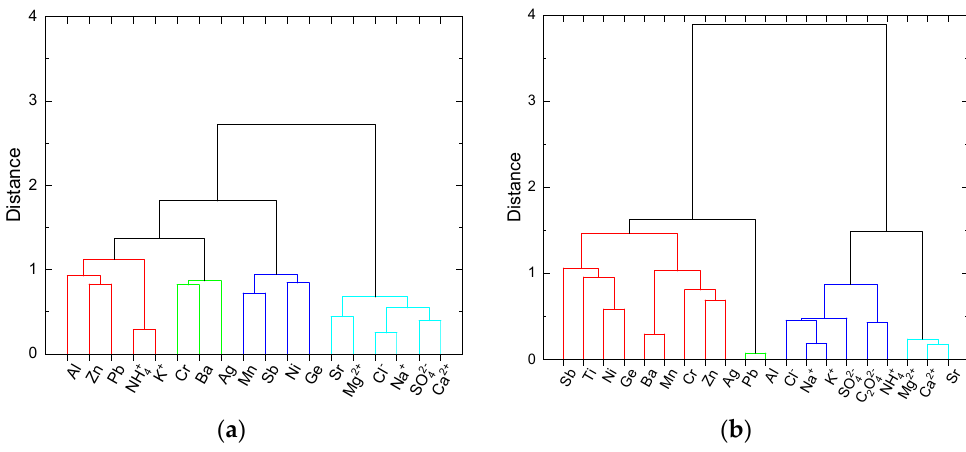
Figure 5. Hierarchical dendrograms showing clustering of water-soluble ions and elements in water ( a ) and sediment ( b ) samples collected in July and October sampling sessions.